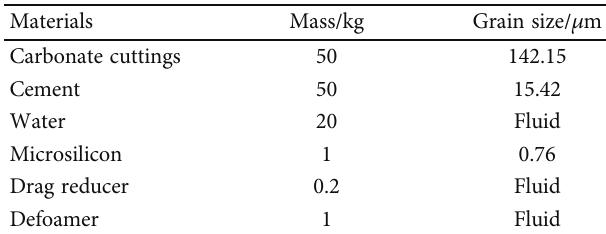
Table 2: The total amount of matrix materials for each borehole